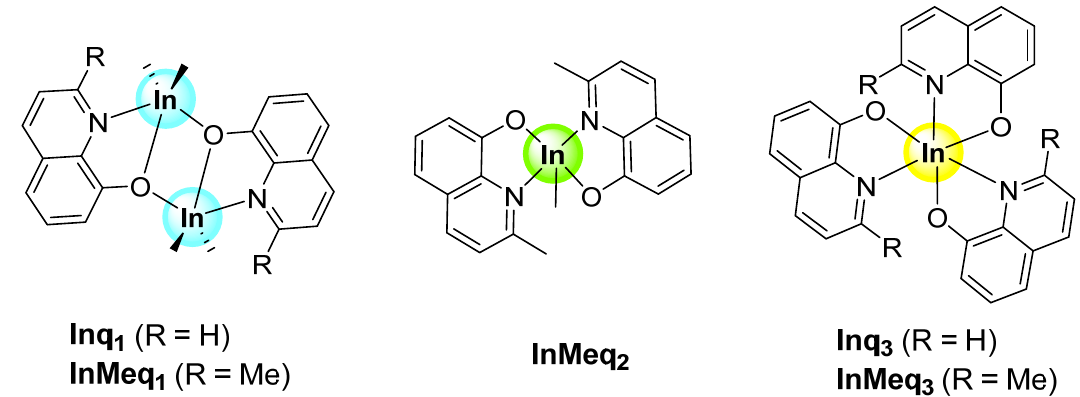
Figure 1. Mono-, bis-, and tris-incorporated indium quinolinate complexes .